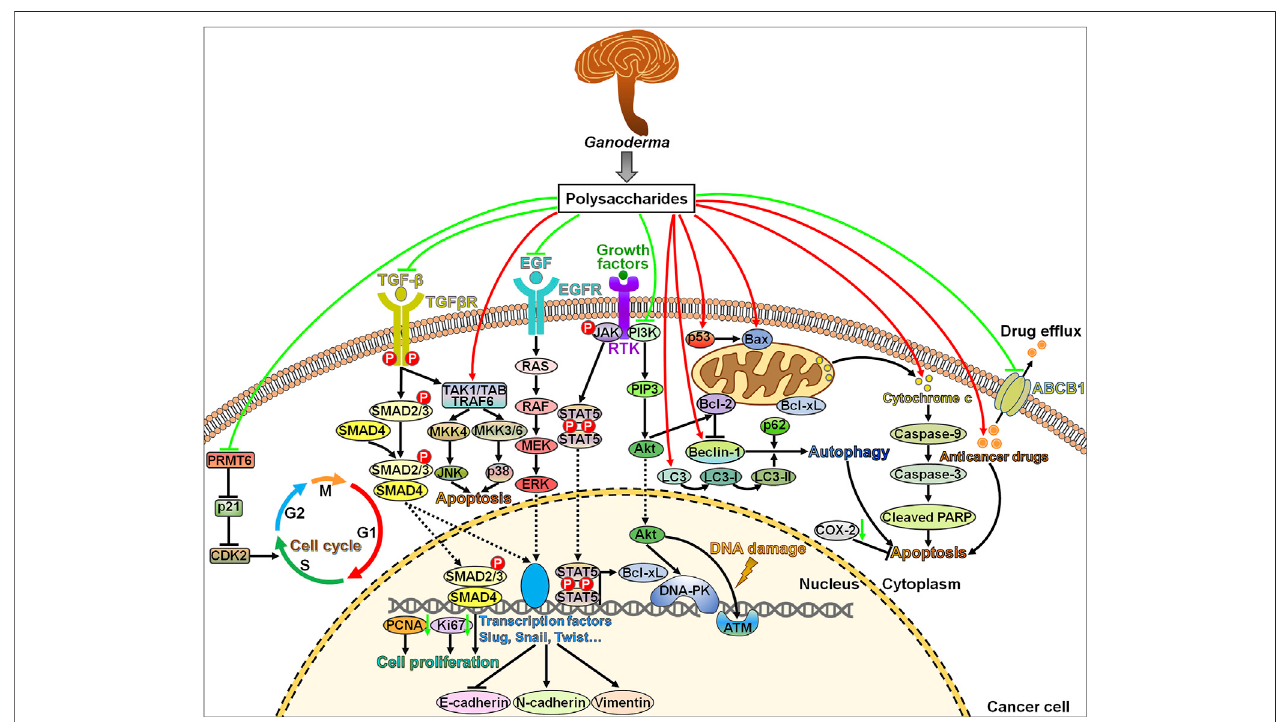
FIGURE 1 | Schematic of the main anticancer molecular mechanisms of Ganoderma polysaccharides. Ganoderma polysaccharides retard cell cycle progression bytargetingthePRMT6/p21/CDK2signalingpathway. Ganoderma polysaccharidesinhibitcancercellproliferationbysuppressingtheTGF- β /SMAD2signalingcascade or downregulating PCNA and Ki67. Ganoderma polysaccharides exert pro-apoptotic actions through modulation of several signal transduction cascades, including the JNK, p38 and JAK/STAT5 signaling pathways. Moreover, they can aggrandize cellular apoptotic response by altering the expression of apoptosis-relevant proteins,such asBax,Bcl-2, caspase-9, caspase-3 and PARP. Ganoderma polysaccharides impedetheEMTprogramincancercellsby inactivating theERK signaling pathway.Intriguingly, Ganoderma polysaccharidesinterferewiththeDNAdamagerepairresponseviarestrictingtheactivitiesofDNA-PKandATMthroughsuppression of the upstream PI3K/Akt signaling cascade. Ganoderma polysaccharides increase the expression of Beclin-1 and LC3 to initiate early autophagic fl ux, which subsequently facilitates cancer cell apoptosis. In addition, Ganoderma polysaccharides augment the pro-apoptotic effect of chemotherapeutic drugs and lower the expression of the drug ef fl ux pump ABCB1, which reinforce the anticancer ef fi cacy of chemotherapeutic drugs. PRMT6, protein arginine methyltransferase 6; CDK2, cyclin-dependent kinase 2; TGF- β , transforming growth factor- β ; TGF β R, transforming growth factor- β receptor; SMAD, small mother against decapentaplegic protein; PCNA, proliferating cell nuclear antigen; TAK1, transforming growth factor- β -activated kinase 1; TAB, TAK1-binding protein; TRAF6, tumor necrosis factor receptor- associated factor 6; MKK, mitogen-activated protein kinase; JNK, c-Jun N-terminal kinase; EGF, epidermal growth factor; EGFR, epidermal growth factor receptor; RAS,ratsarcomavirus;RAF,rapidlyaccelerated fi brosarcoma;MEK,mitogen-activatedprotein/extracellularsignal-regulatedkinase;ERK,extracellularsignal-regulated kinase; JAK, Janus kinase; RTK, receptor tyrosine kinase; STAT5, signal transducer and activator of transcription 5; PI3K, phosphatidylinositol 3-kinase; PIP3, phosphatidylinositol 3,4,5-triphosphate; Akt, protein kinase B; Bcl-xL, B-cell lymphoma-extra large; DNA-PK, DNA-dependent protein kinase; ATM, ataxia- telangiectasia mutated; Bcl-2, B-cell lymphoma-2; Bax, Bcl-2-associated X protein; LC3, microtubule-associated protein light chain 3; COX-2, cyclooxygenase-2; cleaved PARP, cleaved poly (ADP-ribose) polymerase; ABCB1, adenosine triphosphate (ATP)-binding cassette subfamily B member